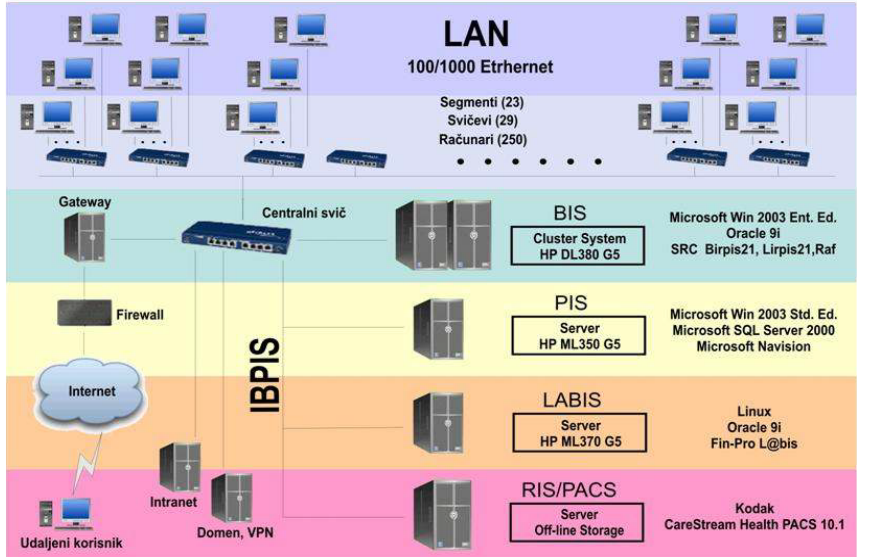
Figure 3 – Integrated hospital information system operating at the Institute of Oncology of